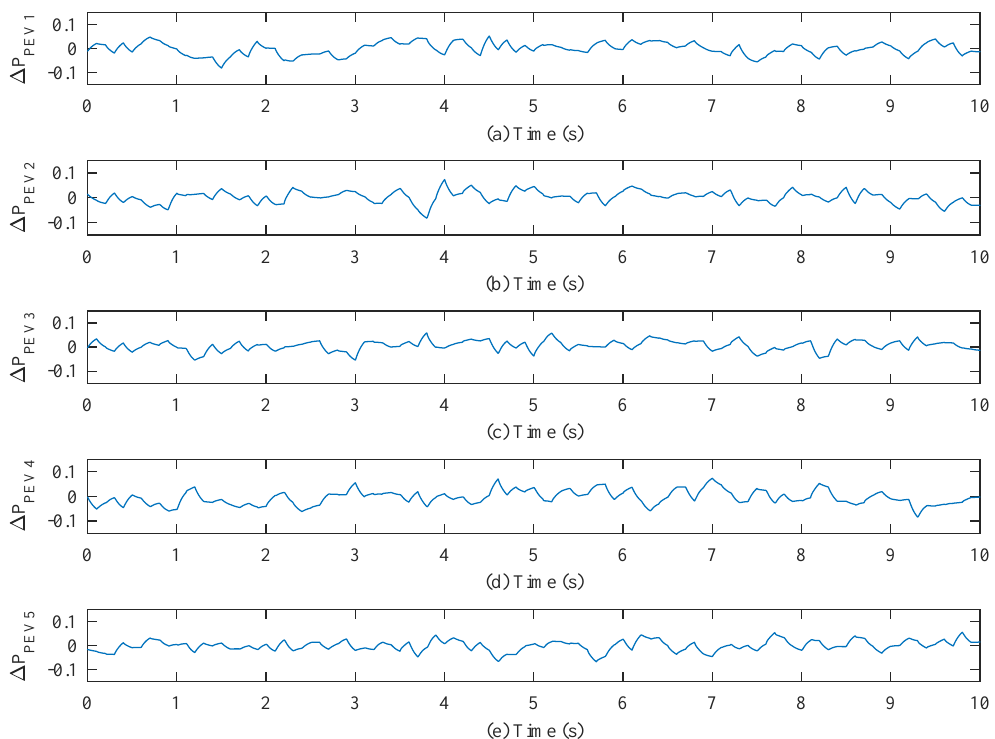
Figure 17. Transient power output of PEV with stochastic disturbance. ( a ) Dynamic response of PEV 1 ; ( b ) dynamic response of PEV 2 ; ( c ) dynamic response of PEV 3 ; ( d ) dynamic response of PEV 4 ; ( e ) dynamic response of PEV 5